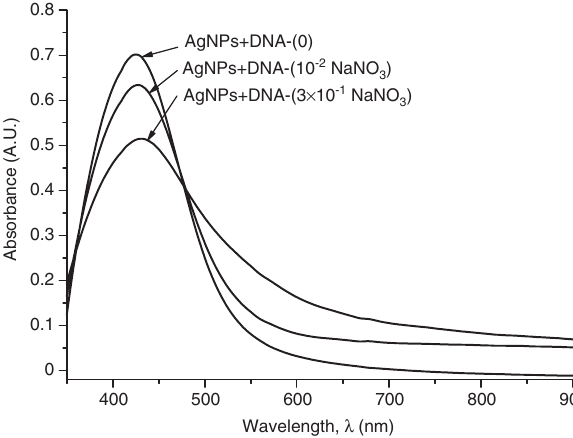
Figure 5 Absorption spectra of AgNPs and DNA after various ion strength applications. [AgNPs] – 0.7 × 10 -4 mol/l (Ag 0 ), [DNA] – 1.8 × 10 -4 mol/l (P), [NaNO